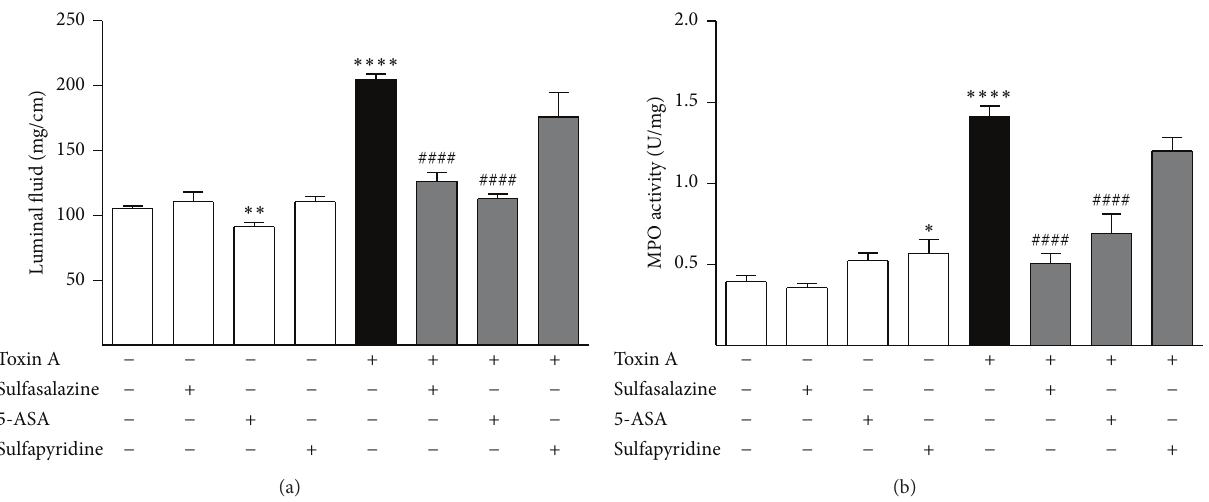
Figure 3: Effects of sulfasalazine, 5-ASA, and sulfapyridine on toxin A-induced colonic luminal fluid accumulation and MPO activity. Sulfasalazine was administered in the drinking water at a dose of 100 mg/kg ⋅ day for 5 days. 5-ASA and sulfapyridine were administered as pretreatments for 30 minutes before toxin A was injected into isolated colonic segments. (a) Toxin A stimulation of colonic luminal fluid accumulation and the inhibition of this effect by chronic treatment with sulfasalazine or acute treatment with 5-ASA or sulfapyridine. (b) Toxin A stimulation of colonic MPO activity and the inhibition of this effect by chronic treatment with sulfasalazine or acute treatment with 5-ASA or sulfapyridine. ∗ 𝑃 < 0.05 versus no treatment; ∗∗ 𝑃 < 0.01 versus no treatment; ∗∗∗∗ 𝑃 < 0.001 versus no treatment; #### 𝑃 < 0.0001 versus toxin